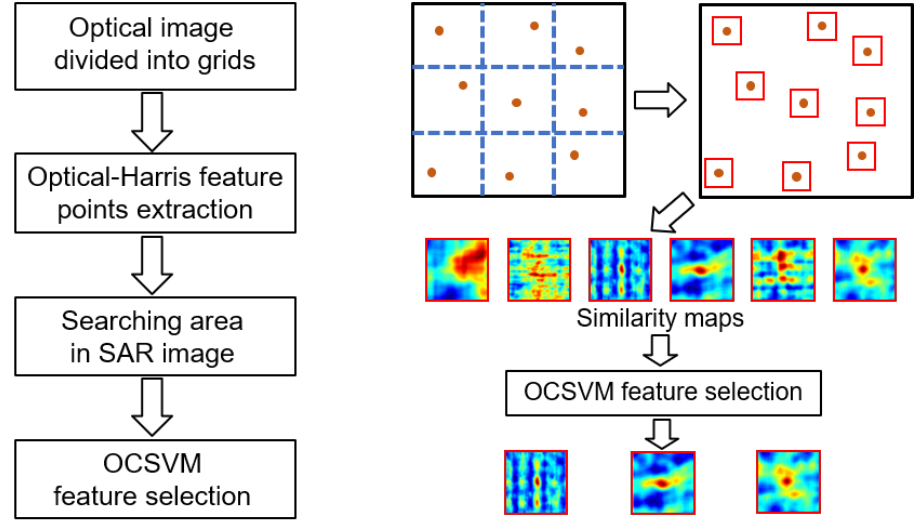
Figure 7. The proposed optical and SAR image registration